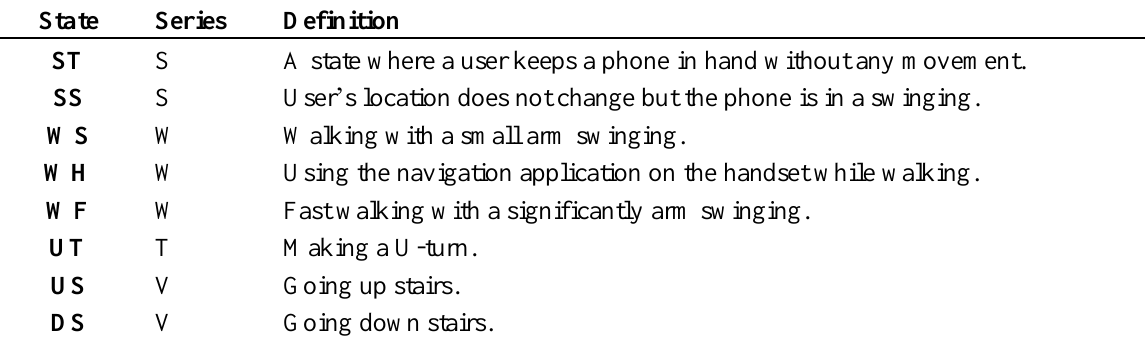
Table 1. Motion state